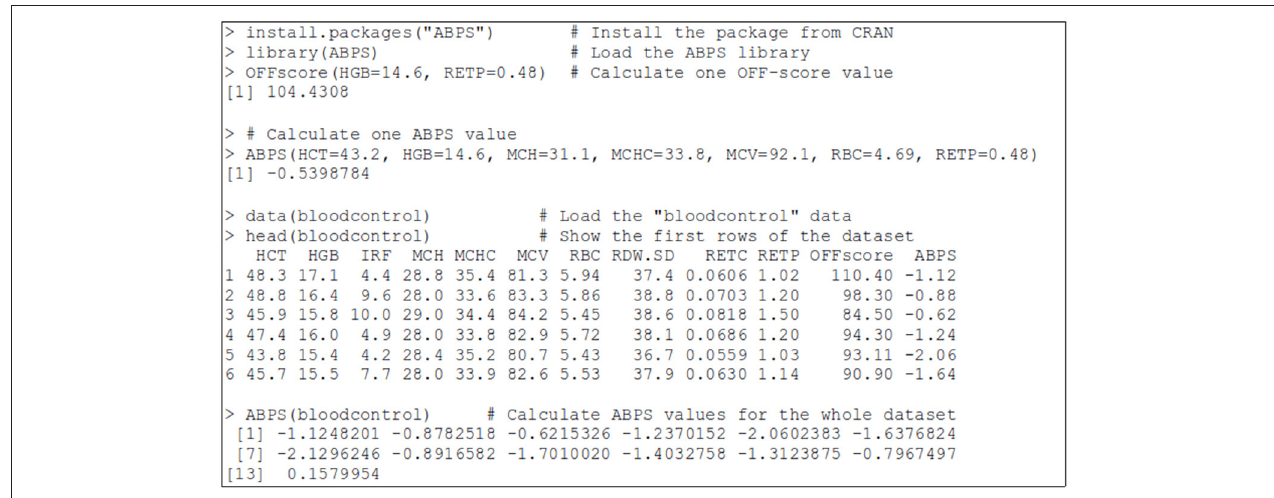
FIGURE 1 | A sample session using the ABPS package within R. During this session, the package is installed, loaded, the some calculations of ABPS and OFF-score are